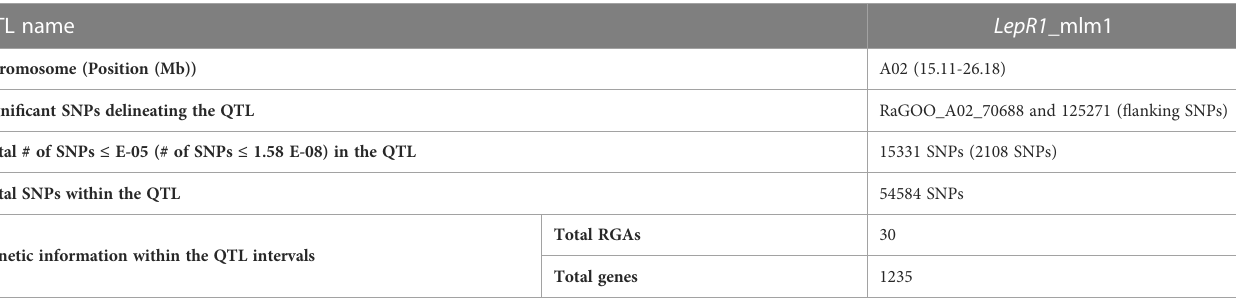
TABLE 1 Delineation of the LepR1 _mlm1 quantitative trait loci (QTL) including number of genes and the resistance gene analogs (RGAs) content using the mixed linear model (MLM) genome-wide association study (GWAS) and its signi fi cant single nucleotide polymorphism (SNP) associated with LepR1 blackleg resistance in Brassica napus.